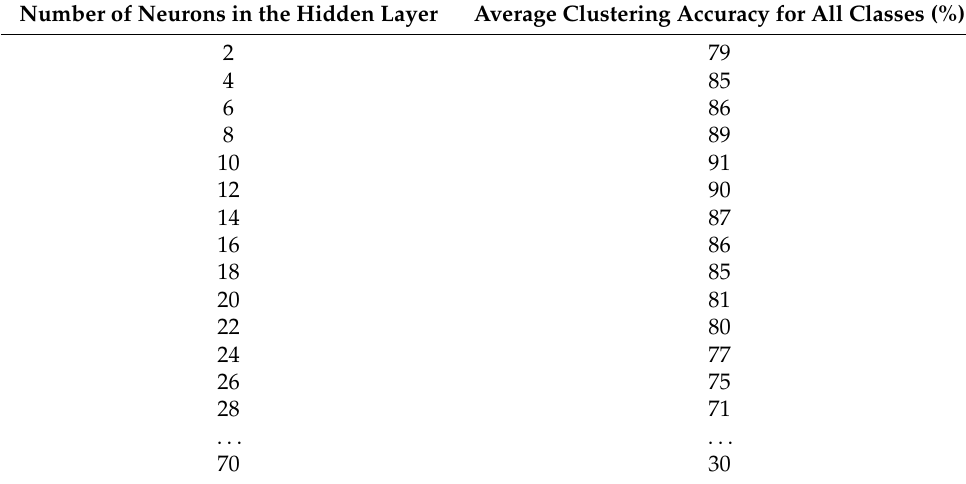
Table 7. Average clustering accuracy for all classes with two hidden layers. Number of Neurons in the Number of Neurons in the Average Clustering Accuracy First Hidden Layer Second Hidden Layer